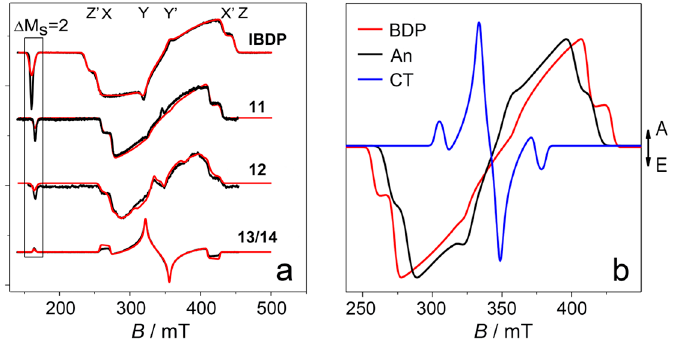
Figure 22. ( a ) TREPR spectra of the anthryl-Bodipy dyads and ( b ) observation of the three triplet states of 3 CT, 3 An and 3 BDP simultaneously for dyad 12 . IBDP refers to 2,6-diiodoBodipy; BDP refers to Bodipy. Reproduced with permission from reference [38], copyright 2019, American Chemical